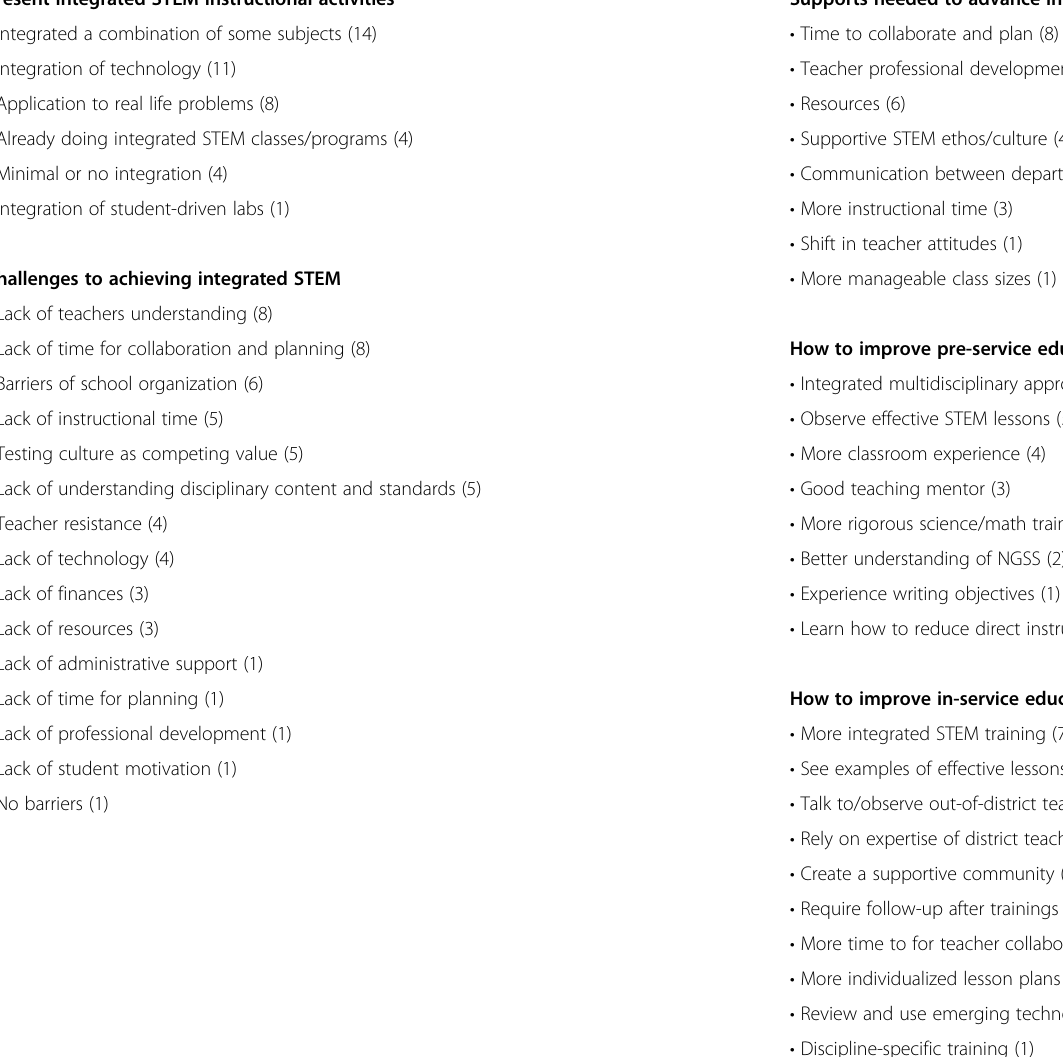
Table 1 Coding categories and frequencies of participants discussing each Present integrated STEM instructional activities Supports needed to advance integrated STEM